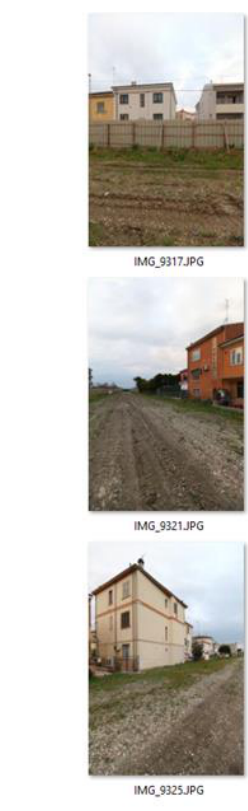
Figure 3. Sequence of the twelve coaxial frames needed to perform the spherical